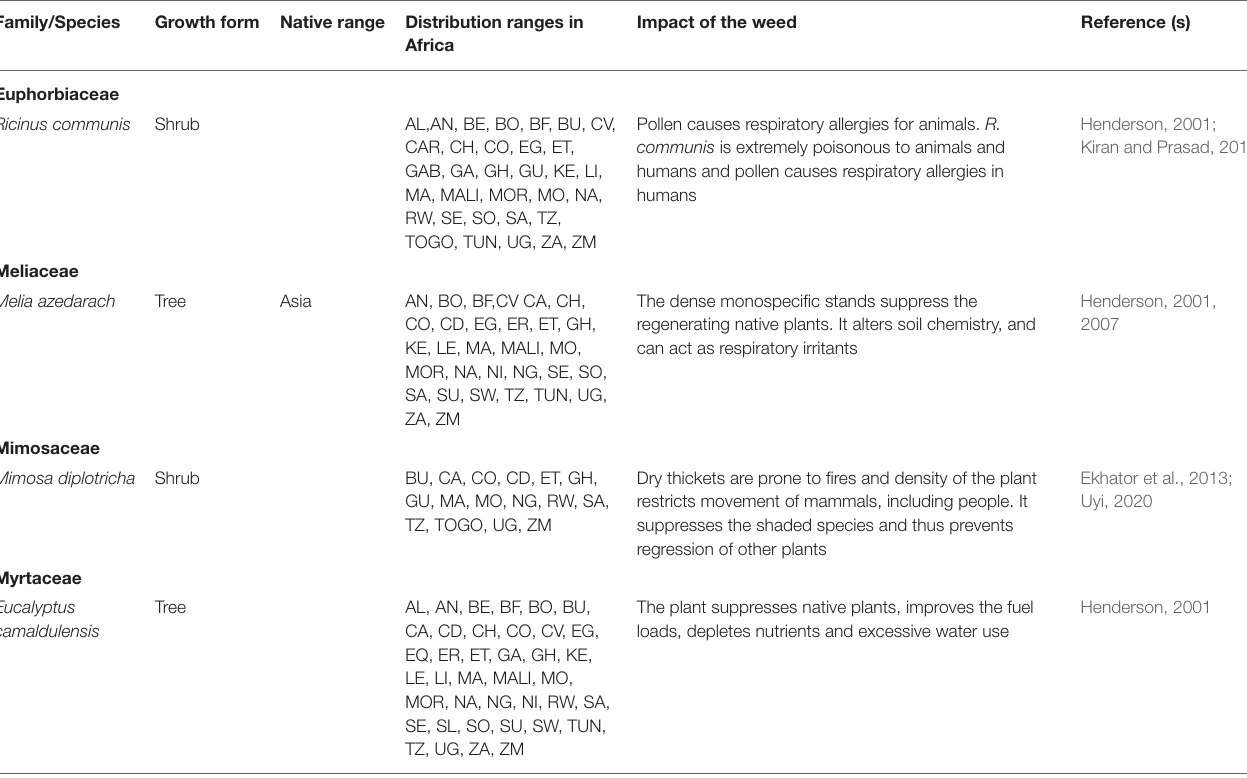
TABLE 1D | Published reports on the impact of some invasive alien plants in sub-Saharan